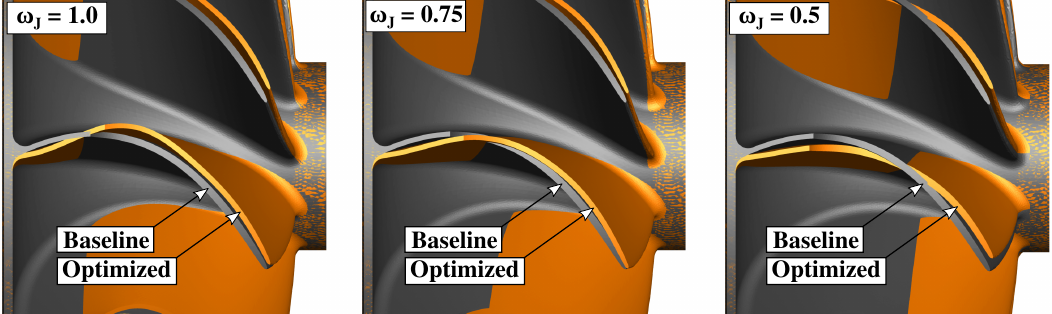
Figure 7. Blade shapes of three optimization runs compared to the baseline geometry. In each optimization, a different weight ω J was given to the moment of inertia and total-to-static efficiency term of the weighted objective